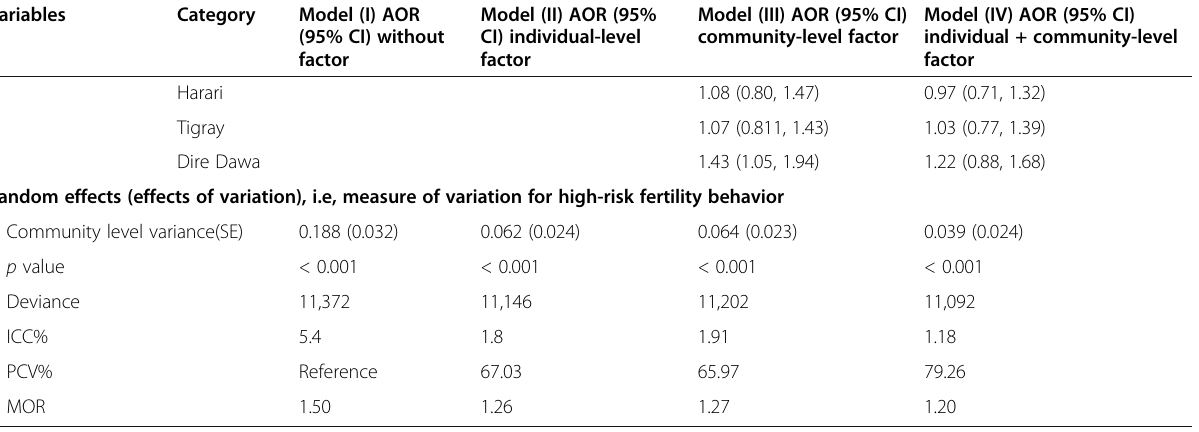
Table 3 Multilevel logistic regression analysis of high-risk fertility behavior among reproductive-age women in Ethiopia, 2016 ( n = 11,022) (Continued)